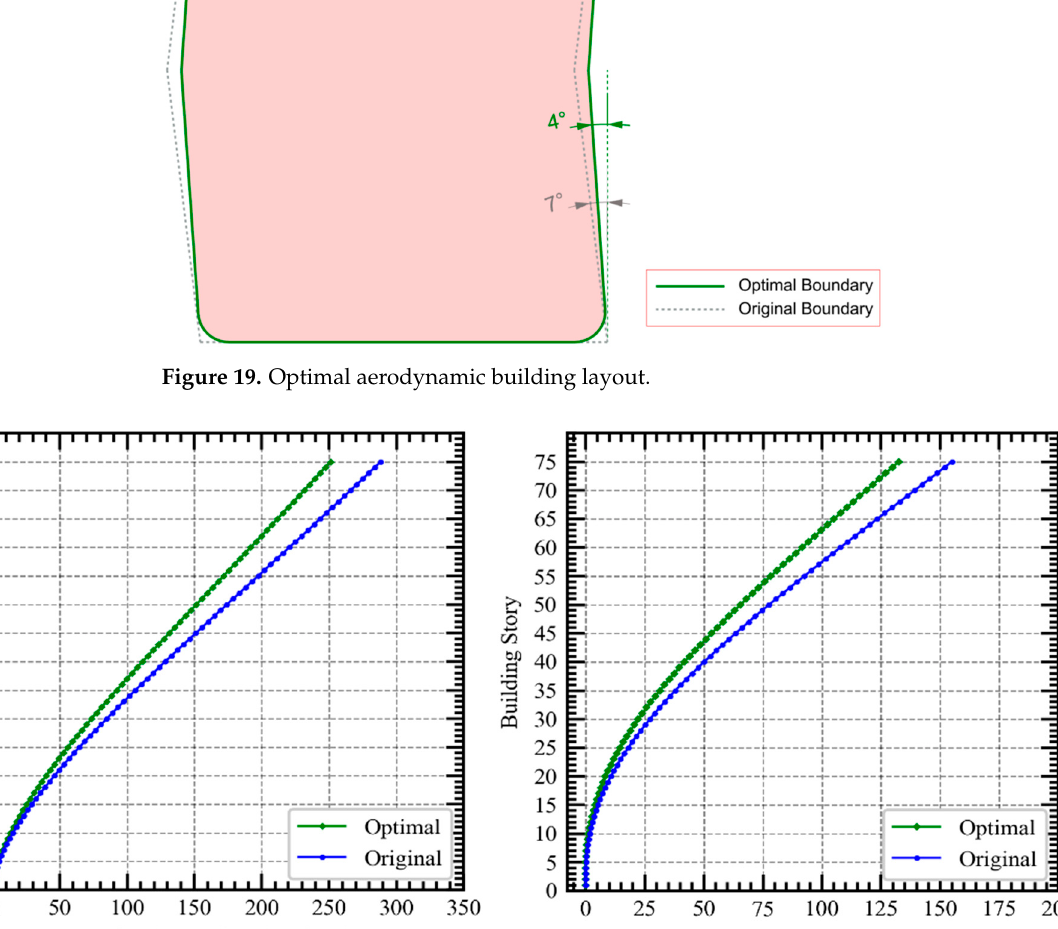
Figure 19. Optimal aerodynamic building layout.